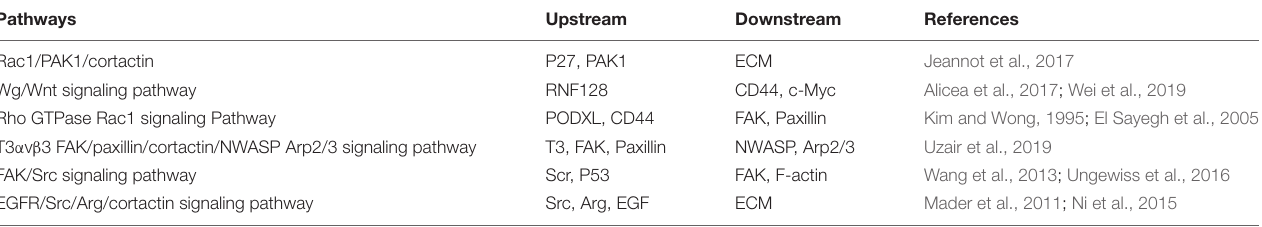
TABLE 1 | Correlated signaling pathways and upstream and downstream molecules related to cortactin-induced epithelial–mesenchymal transition (EMT). Pathways